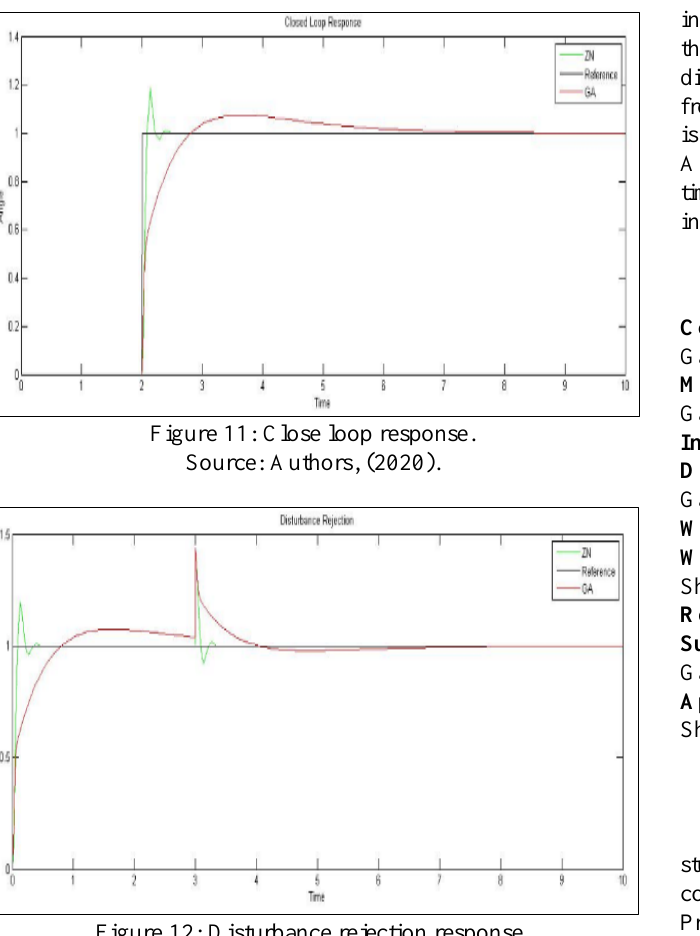
Figure 12: Disturbance rejection response.